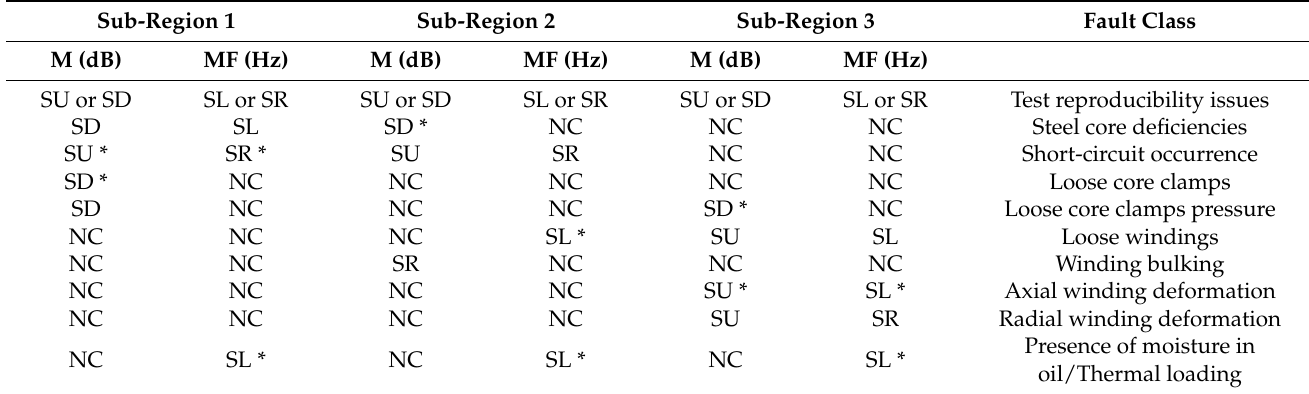
Table 1. FRA profile recommended interpretation code